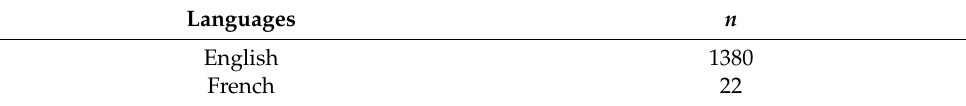
Table 2. Scientific language of publications.